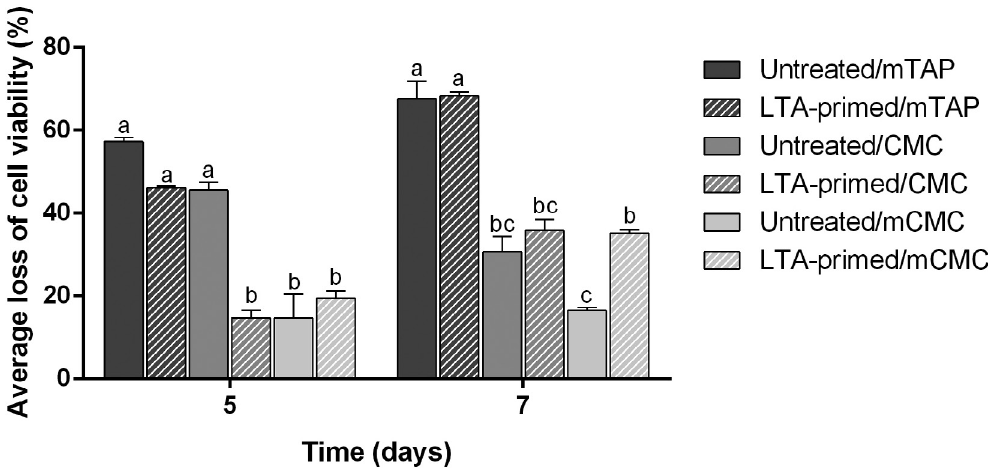
Figure 5- Average loss of cell viability for APC. Data regarding the viability of the tested medications were normalized based on their respective control (Untreated or LTA-primed) for calculation of the percentage of loss of cell viability. Different letters mean statistical significance (p<0.05)